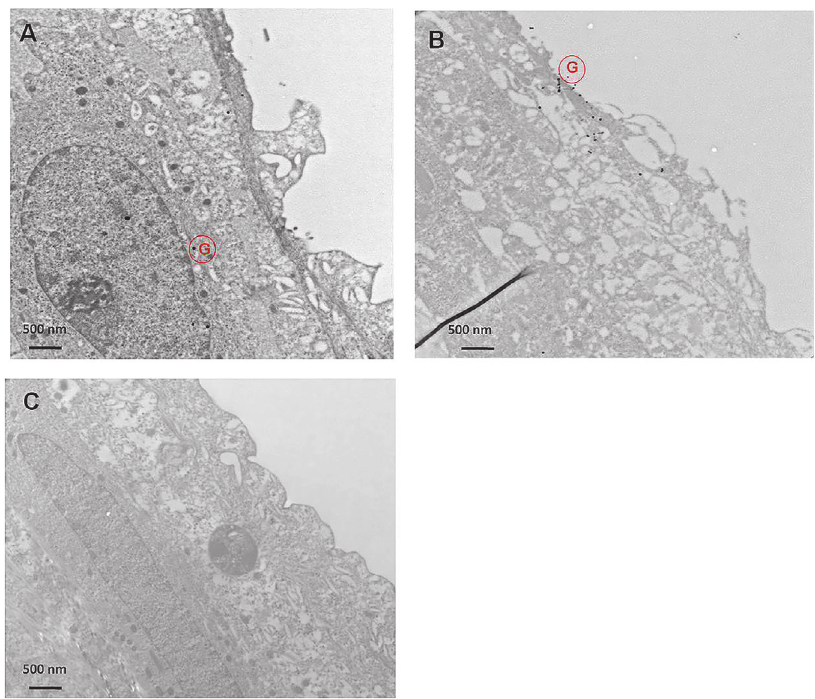
Fig 3. TEM micrographs showing endocytosis mediated uptake of liposome encapsulated gold in rat bladder (A) as revealed by electron dense dark grains consistent with uptake of gold across the urothelium. (B) Dense black grains binding to the cell surface were noted in rat group instilled with colloidal gold in absence of liposomes. Gold encapsulated in liposomes are marked by red colored G inside a red circle and plain gold is marked by yellow G in the images. (C) Untreated rat bladder is marked by (absence of dark black gold grains. Magnification of 8900x was used in all the images and is shown by the scale bar.